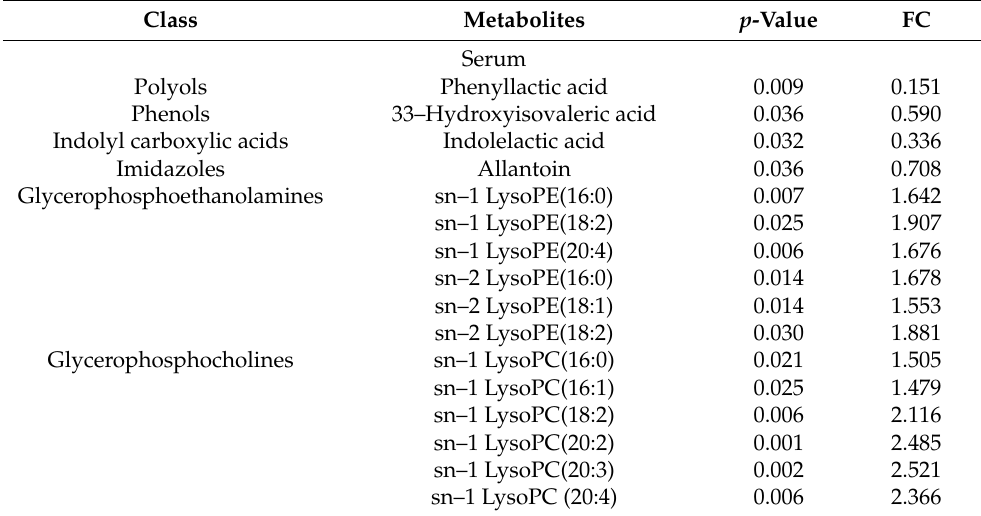
Figure 4. PCA and OLSA-DA analyses of serum and urine metabolites of Hu lambs treated with either control or mannan oligosaccharides milk replacer. ( A ) PCA analyses of serum metabolites; ( B ) volcano plot of serum metabolites; ( C ) PCA analyses of urine metabolites; ( D ) volcano plot of urine metabolites. Lambs were fed milk replacers with or without 0.2% mannan oligosaccharides (MOS; n = 12 per treatment). The serum and urine metabolites in 24 lambs divided into two groups based on MOS supplementation are shown for the 3–week collection phase of the study. Table 3. Differential metabolites in serum and urine samples of Hu lambs treated with either control or mannan